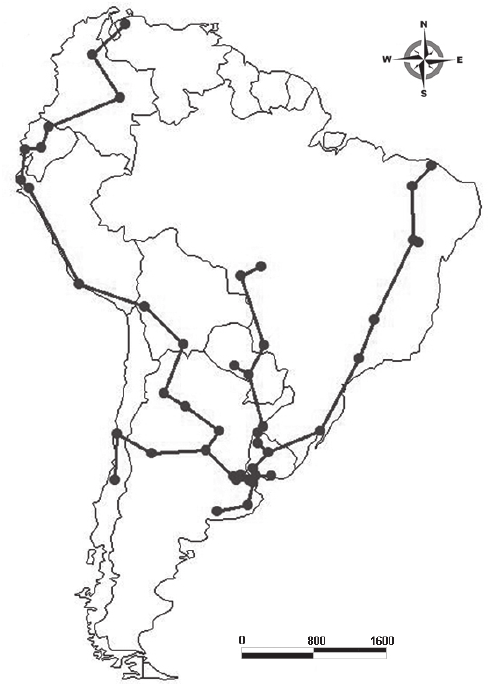
Fig. 6 - Individual track of Glyptotherium sp.